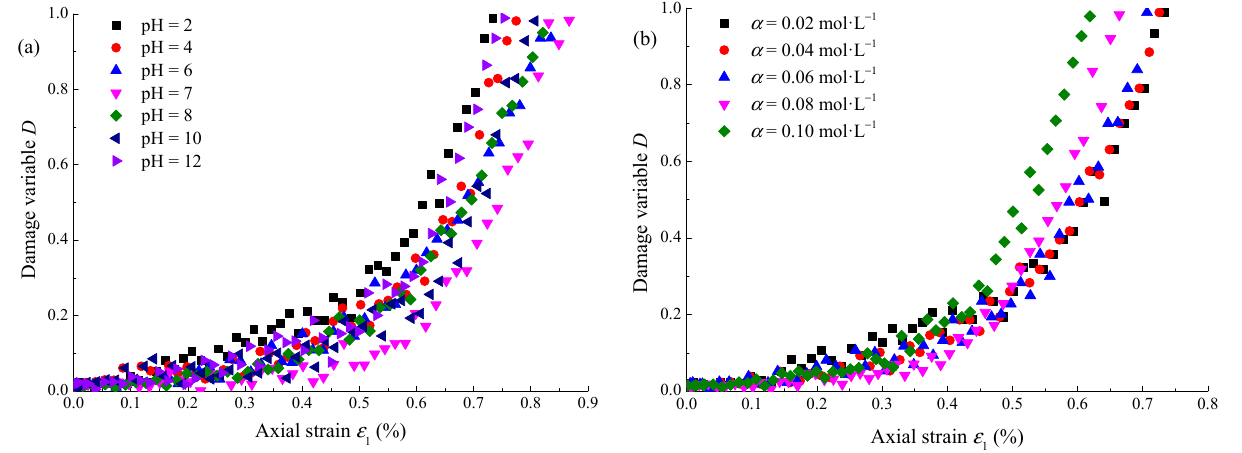
Figure 11. Damage variation evolution curve of Na 2 SO 4 corroded sandstone: ( a ) α = 0.02 mol · L − 1 ; ( b ) pH = 2.